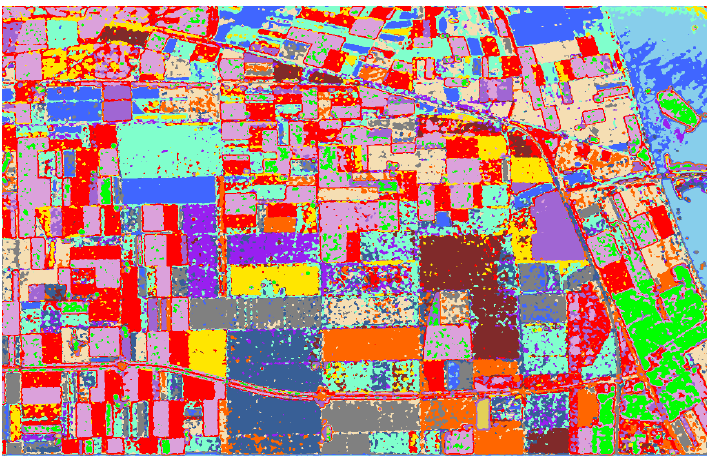
Figure 19. The classification result of the Flevoland image using the supervised Wishart classification